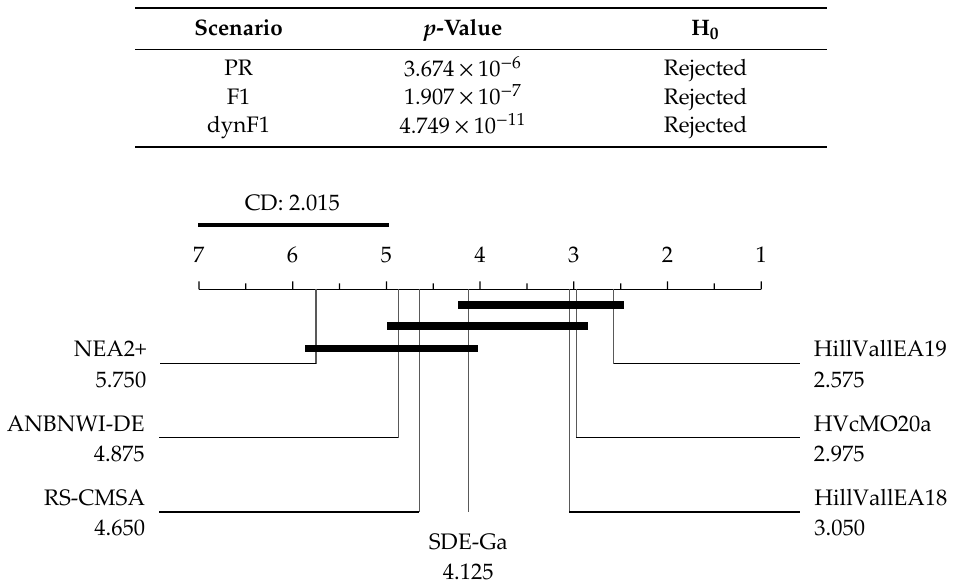
Figure 4. Nemenyi test regarding PR. Connected optimizers are not statistically different.